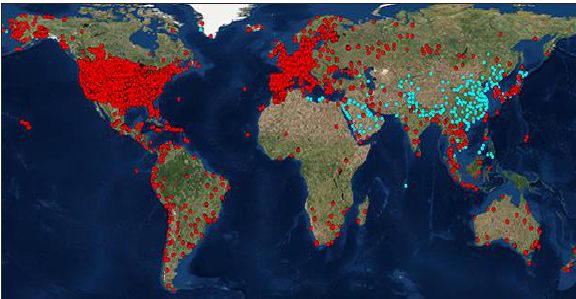
Figure 18. Archived RSGCPs® (blue) supplementing the GCPs (red) in CompassData’s global